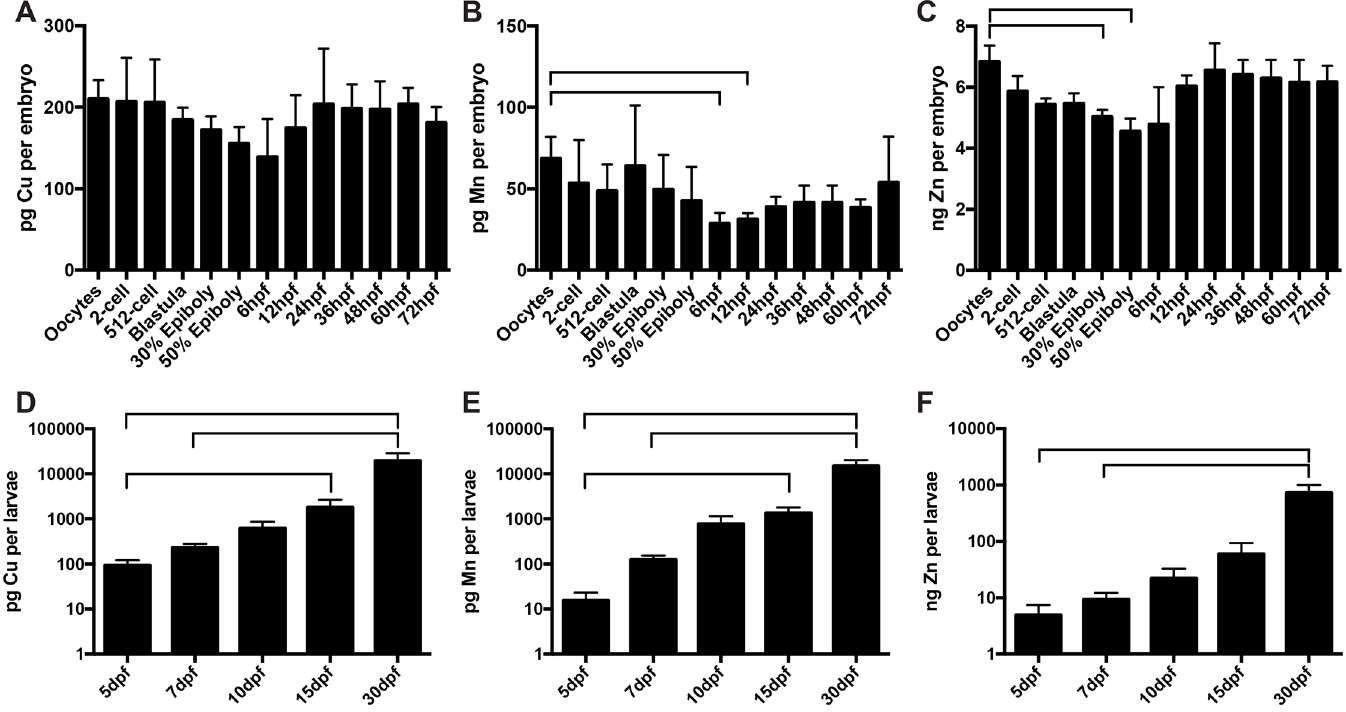
Fig 1. Metal levels in oocytes and embryonic and larval stages of zebrafish. ICP-MS measurements for copper(Cu) (A, D), manganese (Mn) (B, E), and zinc (Zn) (C, F) were performed on oocytes, embryos (2-cell, 512-cell, blastula, 30% epiboly, 50% epiboly,6, 12, 24, 36, 48, 60, 72 hours post- fertilization (hpf)) (A-C) and larval fish (5, 7, 10, 15, 30 days post-fertilization (dpf)) (D-F). Each bar represents the averageand standarddeviationof four to five independently collectedreplicates for a specific developmental stage. Each replicaterepresentsa pooledgroup of 20 oocytes, 10–20 embryos, or 5–10 larvalfish. Metal levels are expressedper oocyte, embryo, or larva. Horizontal brackets above bars indicatea statisticallysignificantdifference between bracketedvalues. (For data in all panels,the Shapiro-Wilk normality test failed, therefore Kruskal-Wallis one-wayANOVA on ranks was performed, with Dunn’smethod used for multiple comparisonand P < 0.05as cut-off for